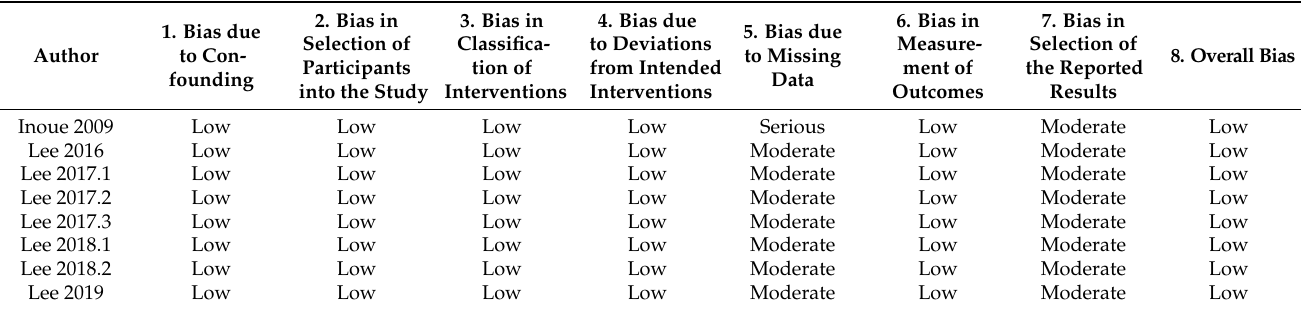
Table 7. The ROBINS-I tool for assessment for non-randomized studies risk of bias, based on the domains confounding, selection, classification of interventions, deviation from intended intervention, missing data, measurement of endpoints, and reporting bias. Each domain was scored as low, moderate, or